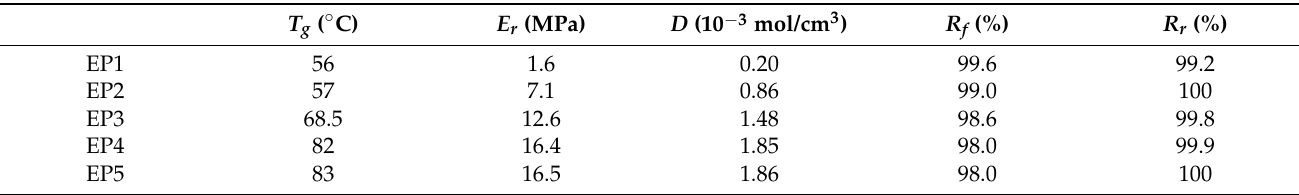
Figure 3. ( a ) Storage modulus and loss factor of different constituted SMEPs (EP1, EP2, EP3, EP4, EP5, respectively, correspond to mole ratio of epoxy monomer to curing agent η = 1.00, 1.25, 1.50, 1.75, 2.00). ( b ) Glass transition temperature, rubbery modulus, and crosslink density as the functions of mole ratio of epoxy monomer to curing agent. Table 3. Detailed information of fabricated different constituted